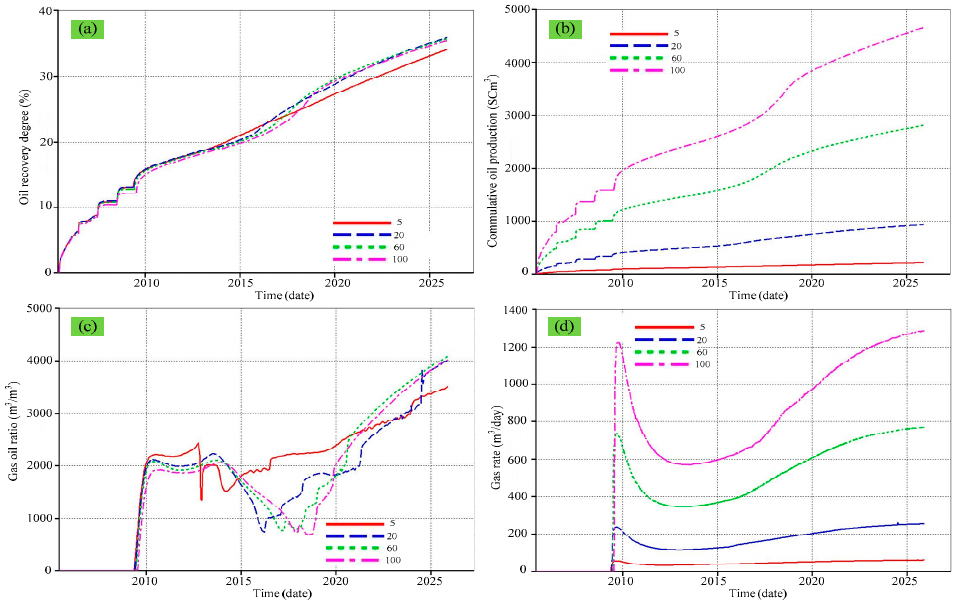
Figure 11. Comparison of production indicators under different oil layer thickness. ( a ) Recovery degree; ( b ) cumulative oil production; ( c ) gas-oil ratio; and ( d ) gas production rate.